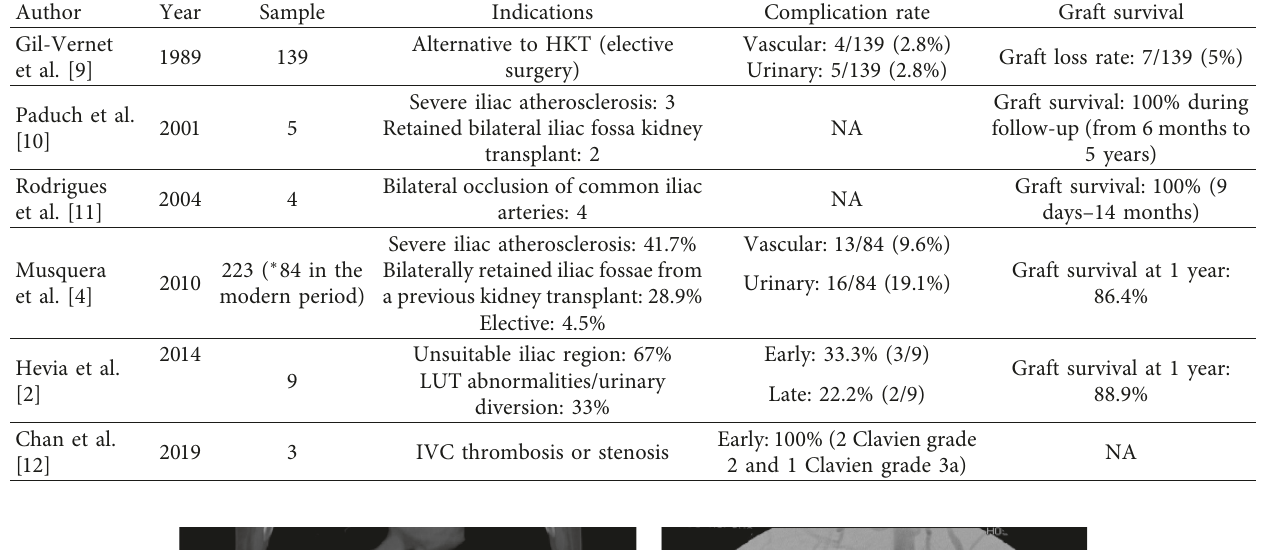
Table 10: Largest series of OKT published in the literature to date.